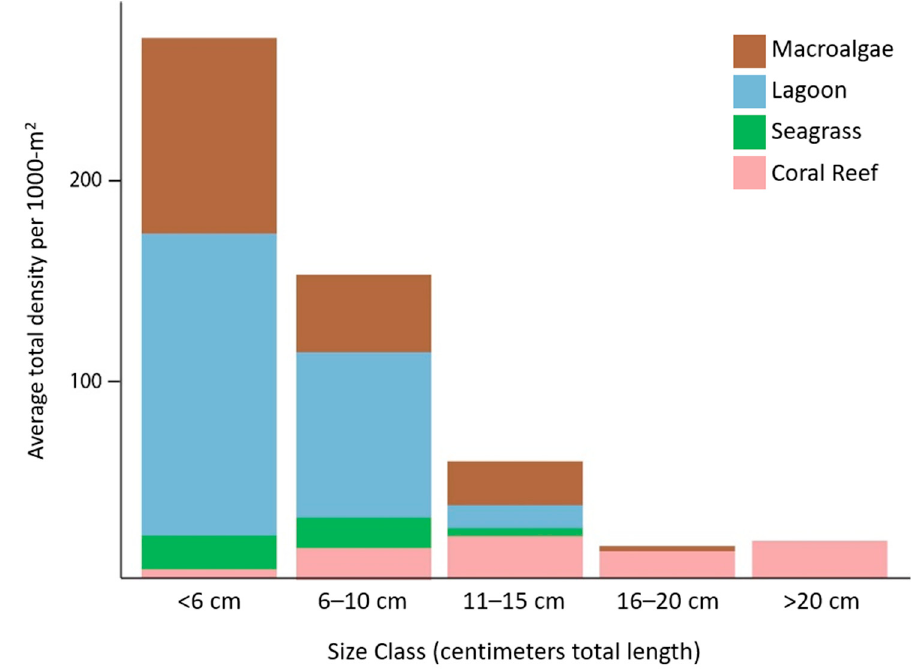
Figure 5. Average parrotfish density of all individuals observed on visual census surveys within each habitat type.